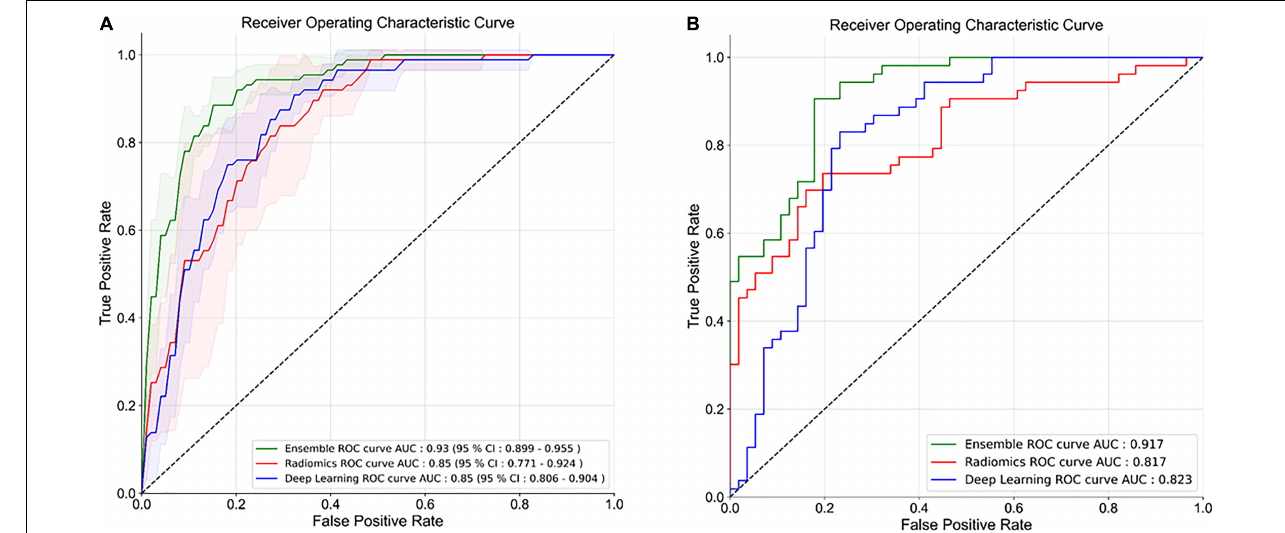
FIGURE 4 | Receiver operating characteristics (ROC) curves for five-fold cross-validation (A) and external test dataset (B) for the classification of IPF and non-IPF ILDs using handcrafted radiomics (HCR), deep learning (DL), and ensemble (HCR + DL) models. TABLE 2 | Precision and recall metrics for five-fold cross-validation using handcrafted radiomics (HCR), deep learning (DL), and an ensemble of HCR and DL models. Model Accuracy Sensitivity Specificity Positive